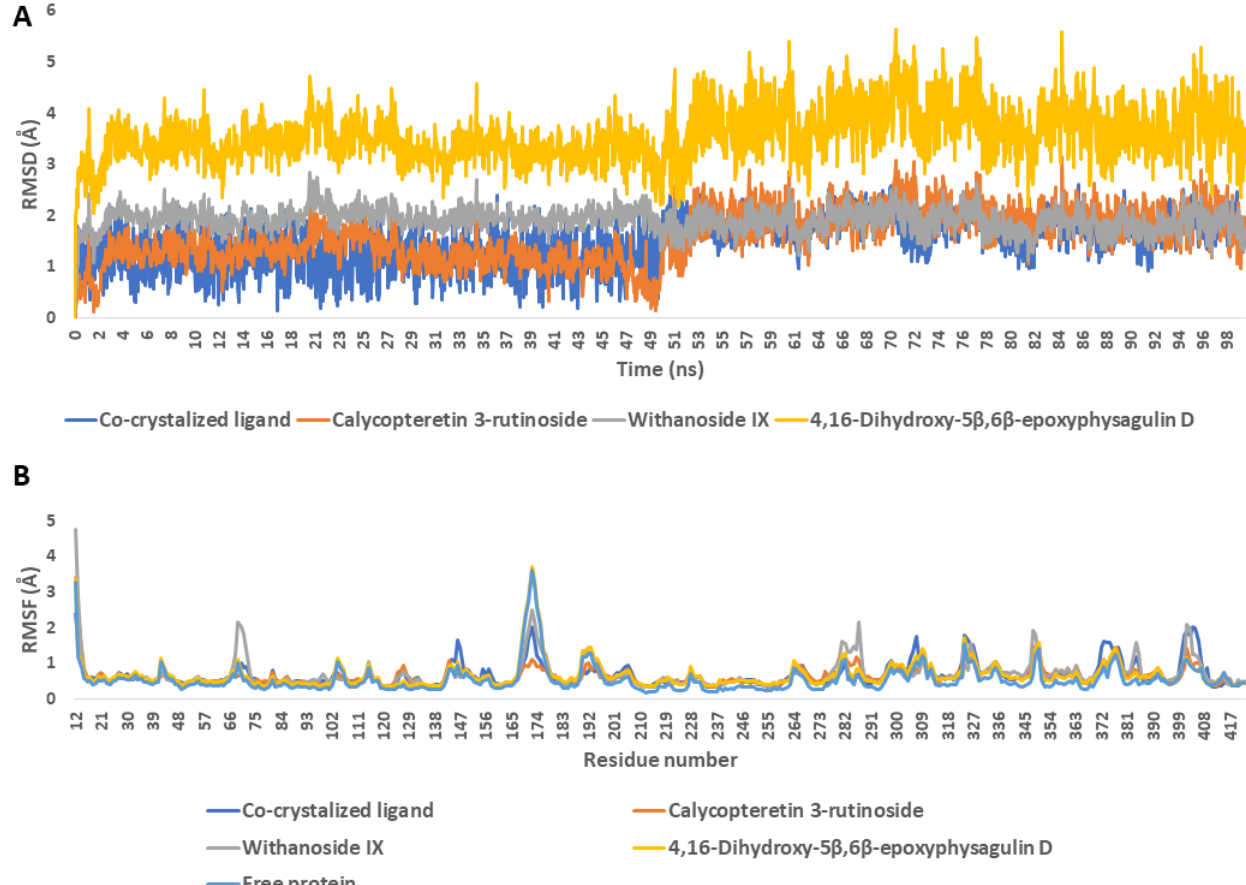
Figure 8. ( A ) RMSDs of the compounds calycopteretin-3-rutinoside, withanoside IX, and 4,16- dihydroxy-5 β ,6 β -epoxyphysagulin D along with the co-crystalized inhibitor inside the active site of NMT (PDB ID: 6QDF) throughout 100 ns MDS runs. ( B ) RMSFs of NMT in the absence and in the presence of calycopteretin-3-rutinoside, withanoside IX, and 4,16-dihydroxy-5 β ,6 β -epoxyphysagulin D along with the co-crystalized inhibitor.